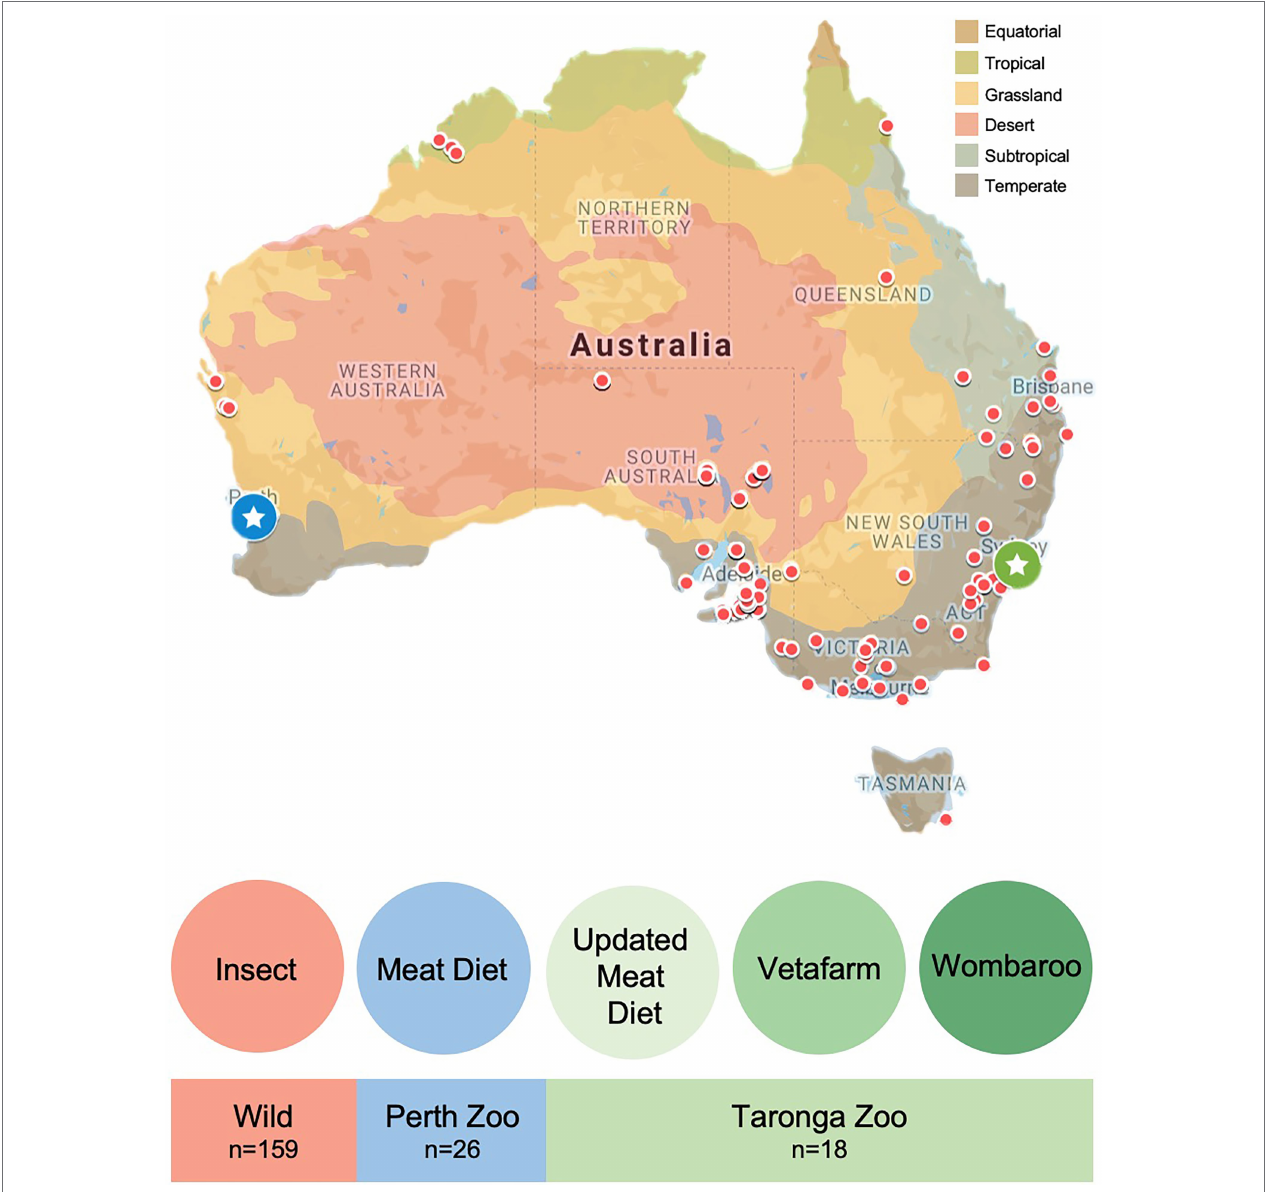
FIGURE 1 | Location and diet information for faecal samples collected from wild and captive echidnas in this study. Red dots on map indicate locations of faecal samples collected from wild echidnas, diet labelled as ‘insect’ for simplicity; blue circle with star is the location of Perth Zoo, where faecal samples were collected from echidnas that were fed exclusively the Meat diet; green circle with star is the location of Taronga Zoo, where faecal samples were collected from echidnas fed three different diets: Updated Meat Diet (UMD), Vetafarm diet and Wombaroo diet. Map is coloured according to Australian climate